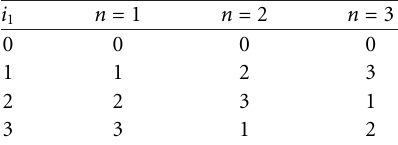
Table 2: The generated